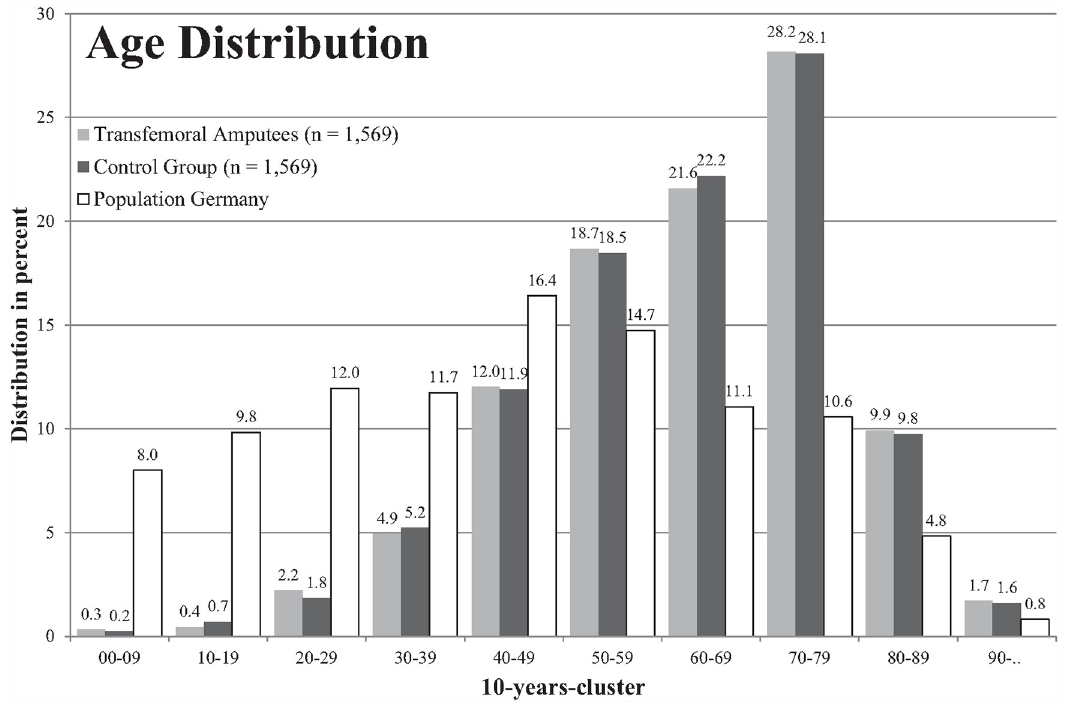
Fig 1. Age distribution of the amputee (light grey) and control group (black) compared to the general German population (blank).